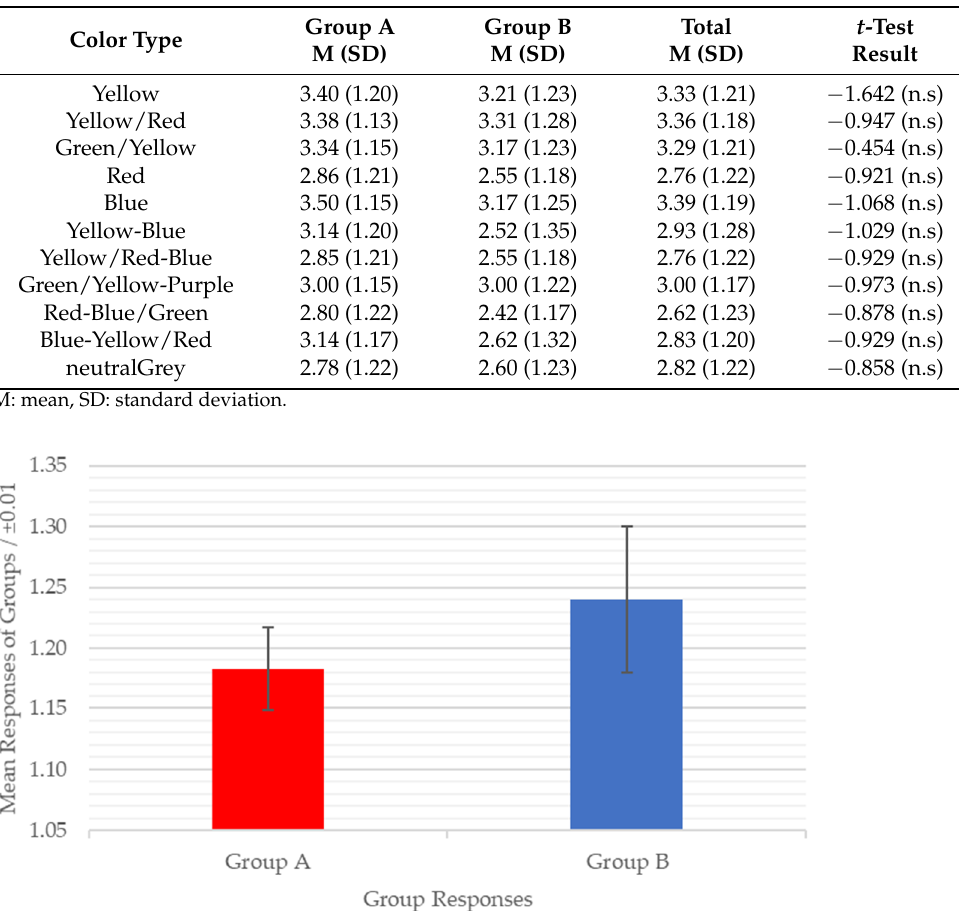
Figure 8. Graph of the mean response and standard deviation of ‘Pleasure’ for stimuli color images.